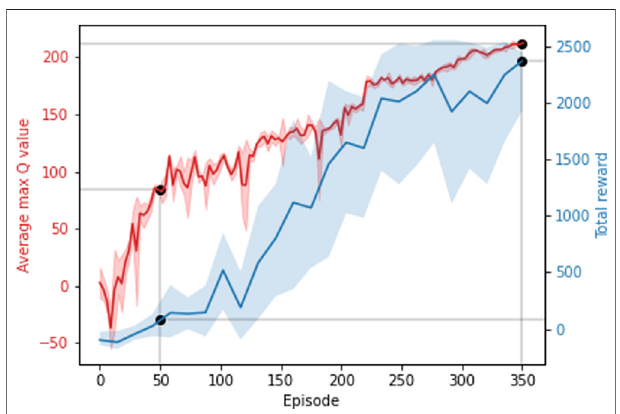
FIGURE 6 | Average max Q-value and total reward across training episodes. Showing the Average max Q-value and the total reward at 50 and 350